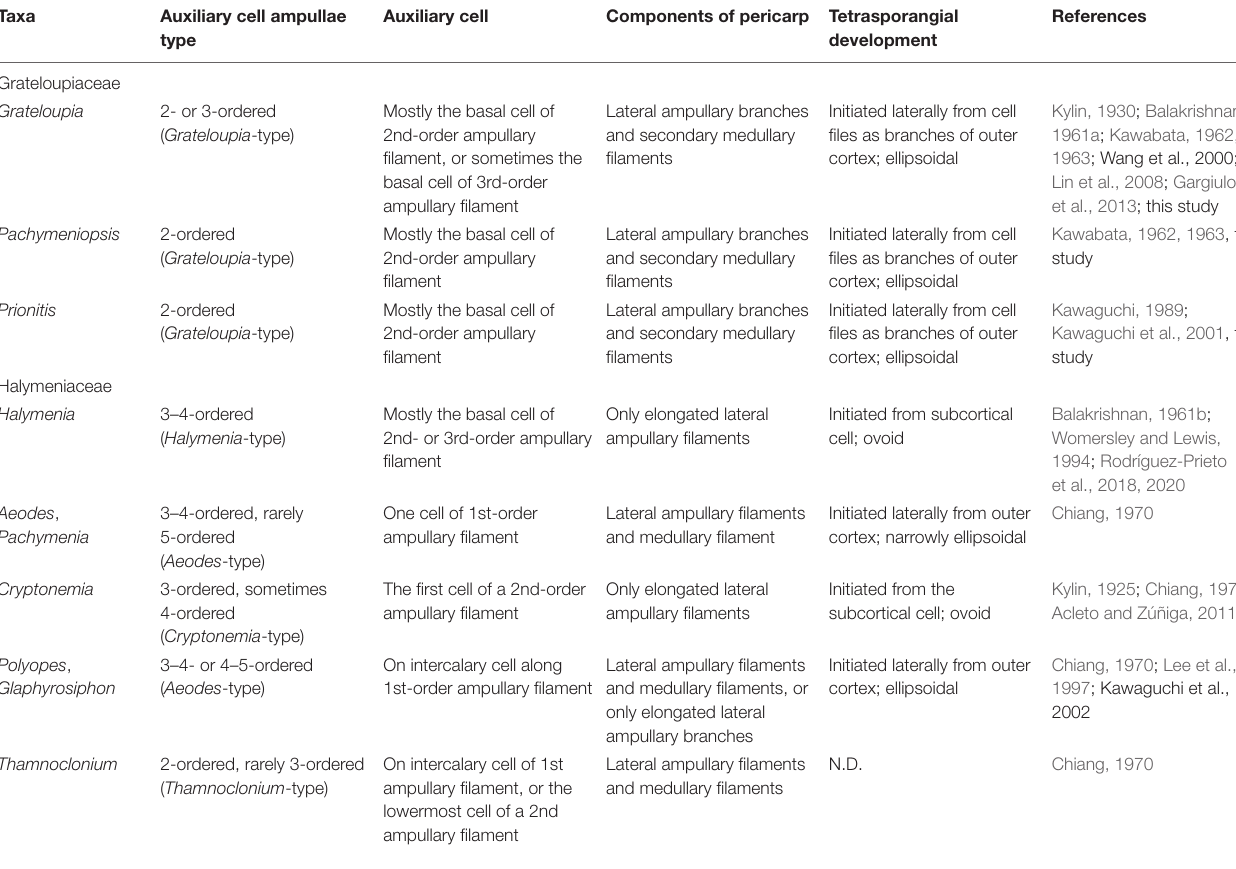
TABLE 1 | The comparison of the reproductive structures of the representative members of Grateloupiaceae and Halymeniaceae, respectively.